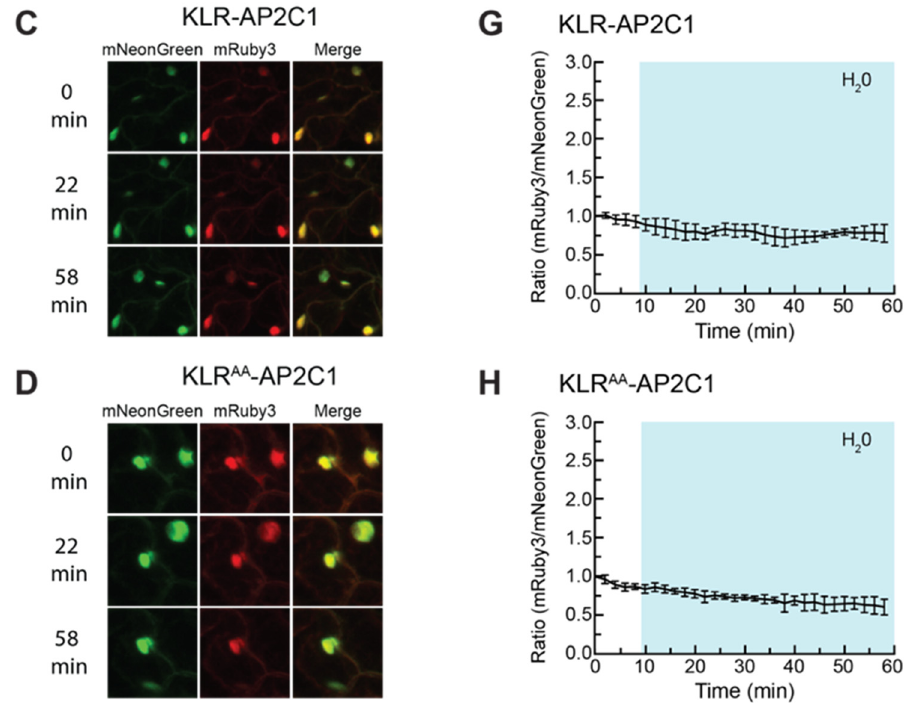
Figure 6. KLR-AP2C1 exhibits a transient reduction in nuclear mNeonGreen fluorescence in response to chitin treatment. ( A – D ) Arabidopsis cotyledons expressing KLR-AP2C1 or KLR AA -AP2C1 were treated with 40 mg / mL chitin ( A , B ) or 200 µ L water ( C , D ) and imaged every two minutes using confocal microscopy at 20 × optical magnification. The mNeonGreen, mRuby3, and merged channels for the 0 min, 22 min, and 58 min time points are shown for each experiment. mNeonGreen emission is shown in green. mRuby3 emission is shown in red. ( E – H ) Quantification of the nuclear fluorescent emission for the experiments shown in ( A – D ). Each data point represents the ratio of the average mNeonGreen and mRuby3 emission intensities within four regions of interest (ROIs) corresponding to cell nuclei. The data were normalized by dividing each value in the time-course by the 0 min value. The shaded background on each graph indicates when the sample was exposed to a given treatment. During the first 10 min of each experiment the samples were incubated in pure water. Error bars indicate standard deviation. Videos are available as Movies